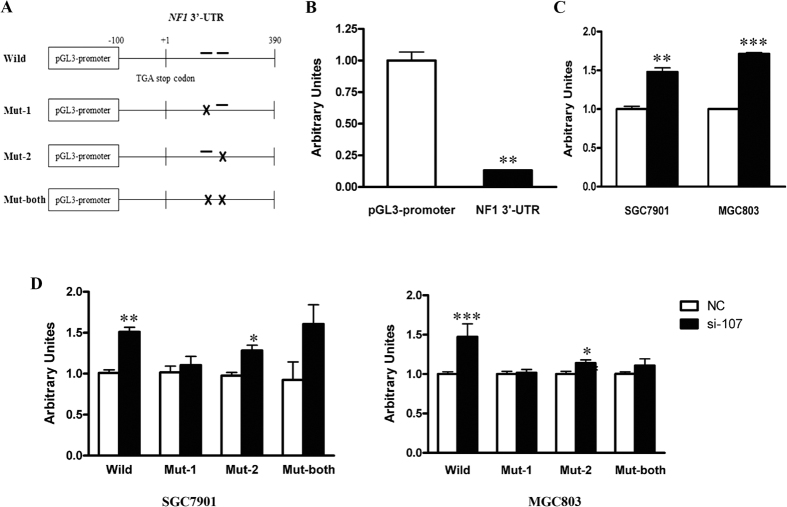
miR-107 negatively regulates NF1 expression by directly targeting its 3′-UTR.(A) Partial sequences of NF1 3′-UTR containing wild or mutated putative miR-107 target sites were fused to the firefly luciferase coding sequence. Bars, predicted miR-107 seed-pairing sequences. (B) The pGL3-NF1 3′-UTR reporter (Wild) and pGL3-promoter plasmids were transfected into MGC803 cells respectively to compare their luciferase activity. (C) The Wild plasmid was co-transfected into MGC803 cells with NC or si-107. (D) The Wild and three mutated plasmids (Mut-1, Mut-2 and Mut-both) were respectively co-transfected into SGC7901 and MGC803 cells with NC or si-107. Luciferase activity was normalized to a simultaneously transfected Renilla expression plasmid. *P < 0.05, **P < 0.01 and ***P < 0.001.